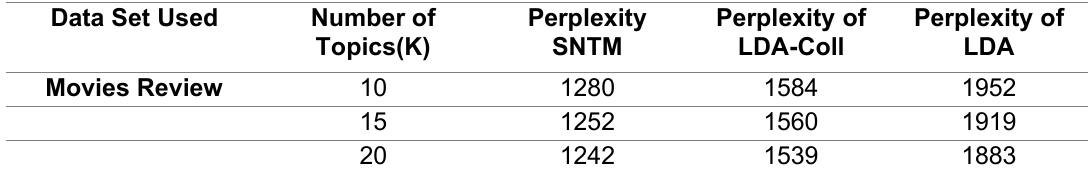
Table 1. Perplexity score of LDA topic model and Semantic N-Gram topic modeling with different number of